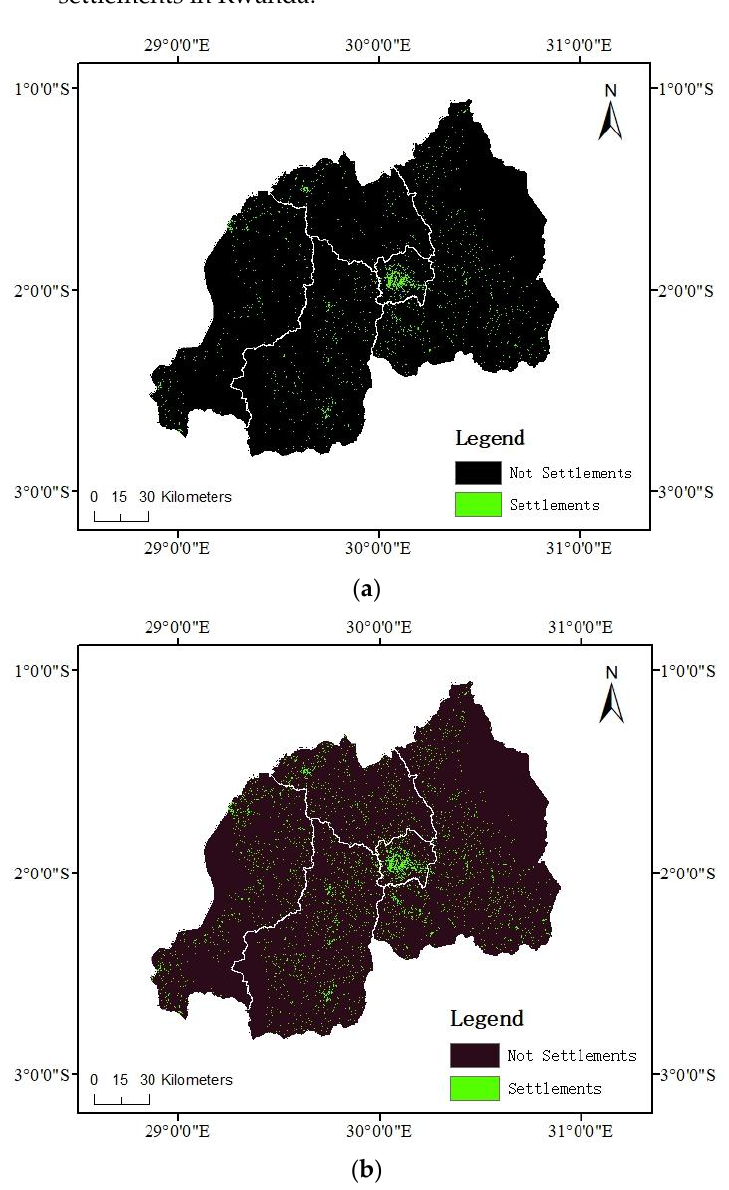
Figure 3. The human settlement map in Rwanda: ( a ) 2015; ( b ) 2019.